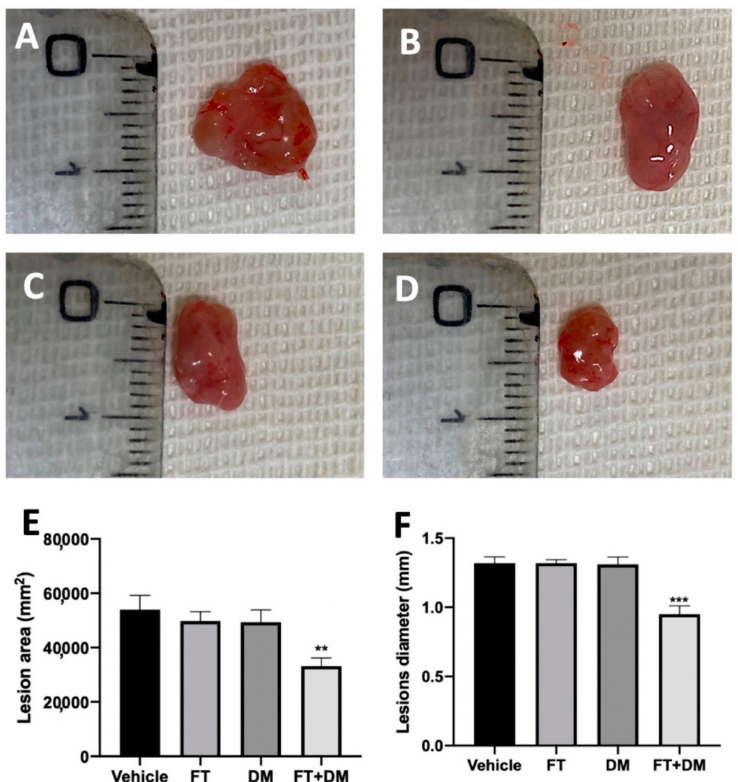
Figure 2. FT+DM administration reduced the size of endometrioc foci (macroscopic analysis): vehicle ( A ), FT ( B ), DM ( C ), FT+DM ( D ), lesion area ( E ), lesion diameter ( F ). A p -value of less than 0.05 was considered significant: ** p < 0.01 vs. vehicle, *** p < 0.001 vs.